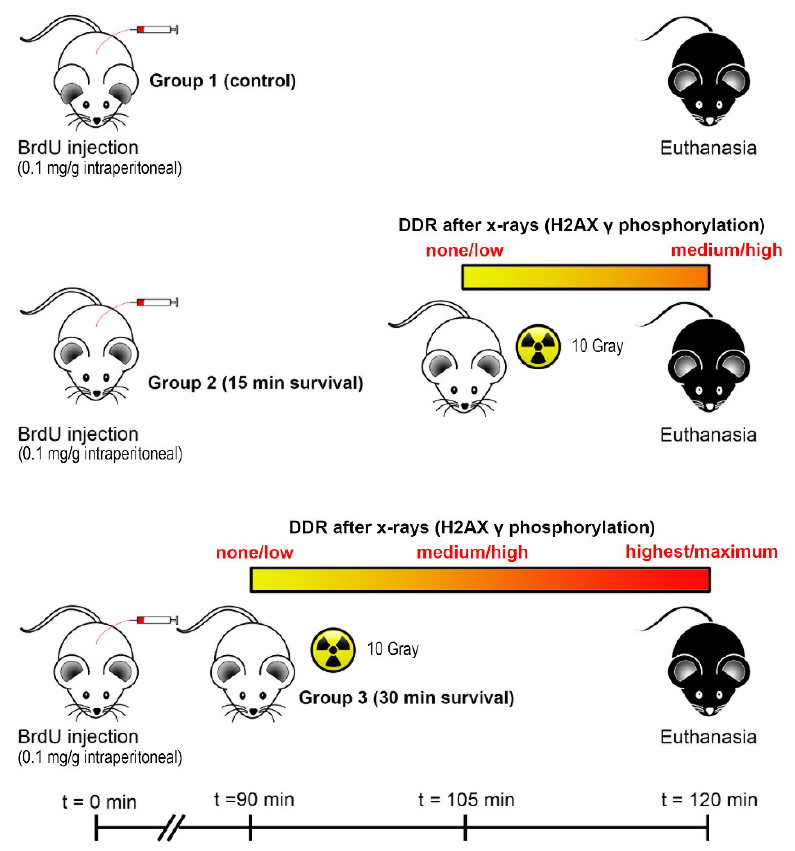
Figure 1. Schematic layout of the X-ray irradiation and control experiments. Experiments are designed such that all animals survive exactly two hours after injection of the DNA synthesis marker BrdU. The colored bars represent, pictorially, H2AX γ phosphorylation, according to literature data showing that γ H2AX appears rapidly following cell exposure to ionizing radiations [18]. The amount of γ H2AX directly correlates to the number of DSBs and, thus, to the extent of DNA damage [19]. As such, this experimental layout allows the study of the early temporal evolution of H2AX γ phosphorylation/DNA damage in vivo